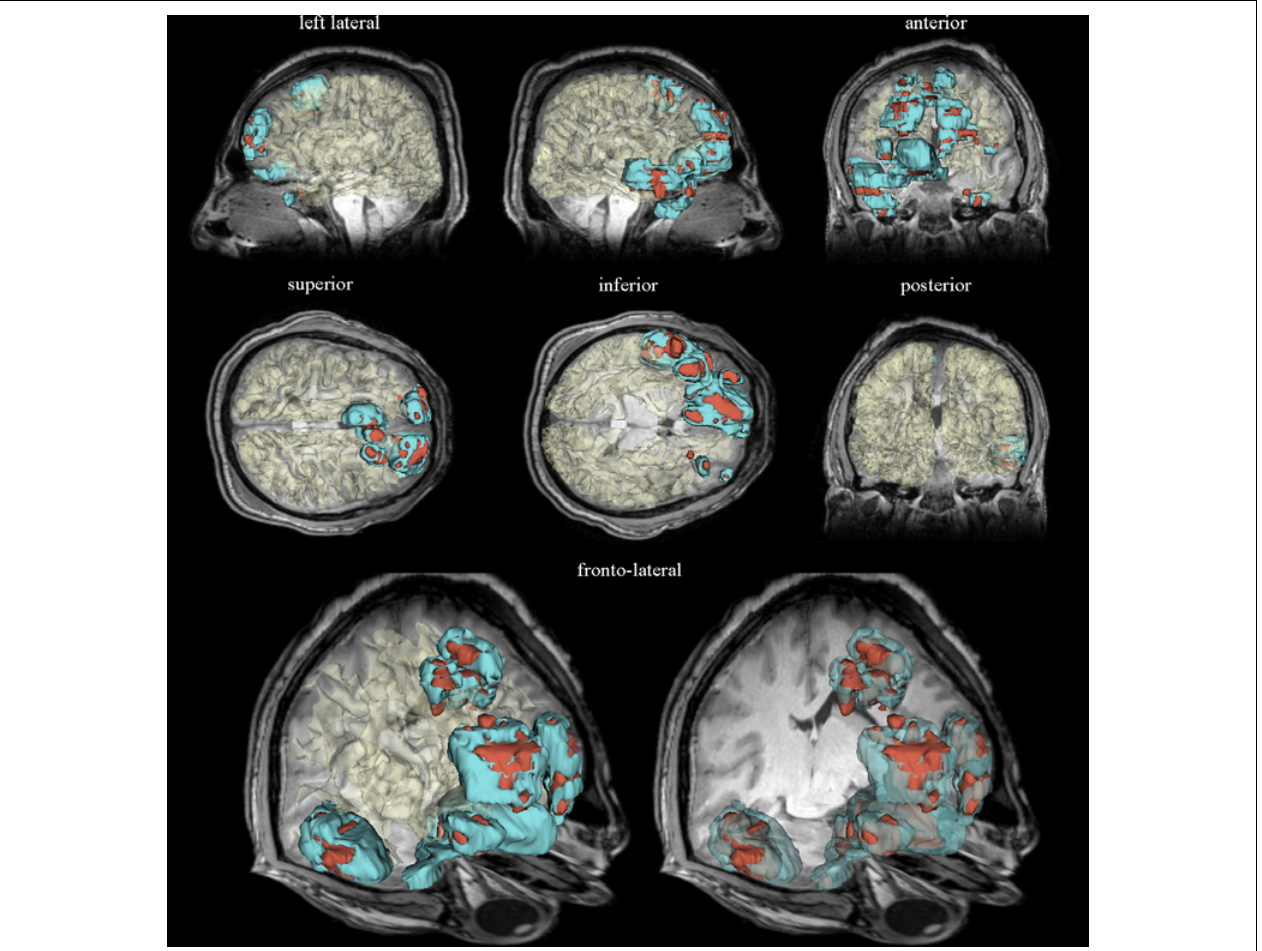
automatically using FreeSurfer, demonstrating the capabilities of this software package to perform automatic tissue classification of healthy-appearing tissues.TheWM model is translucent in each brain view to facilitate the visibility of anatomic details obviated in the MR volume slice displayed. See Irimia etal. (2011) for a detailed description of the neuroinformatics methodology used to generate these